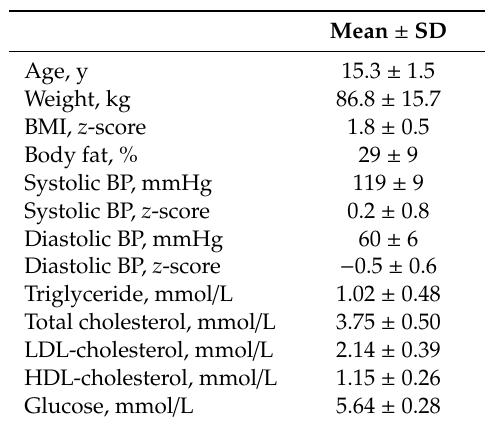
Table 1. Participant screening characteristics ( n =